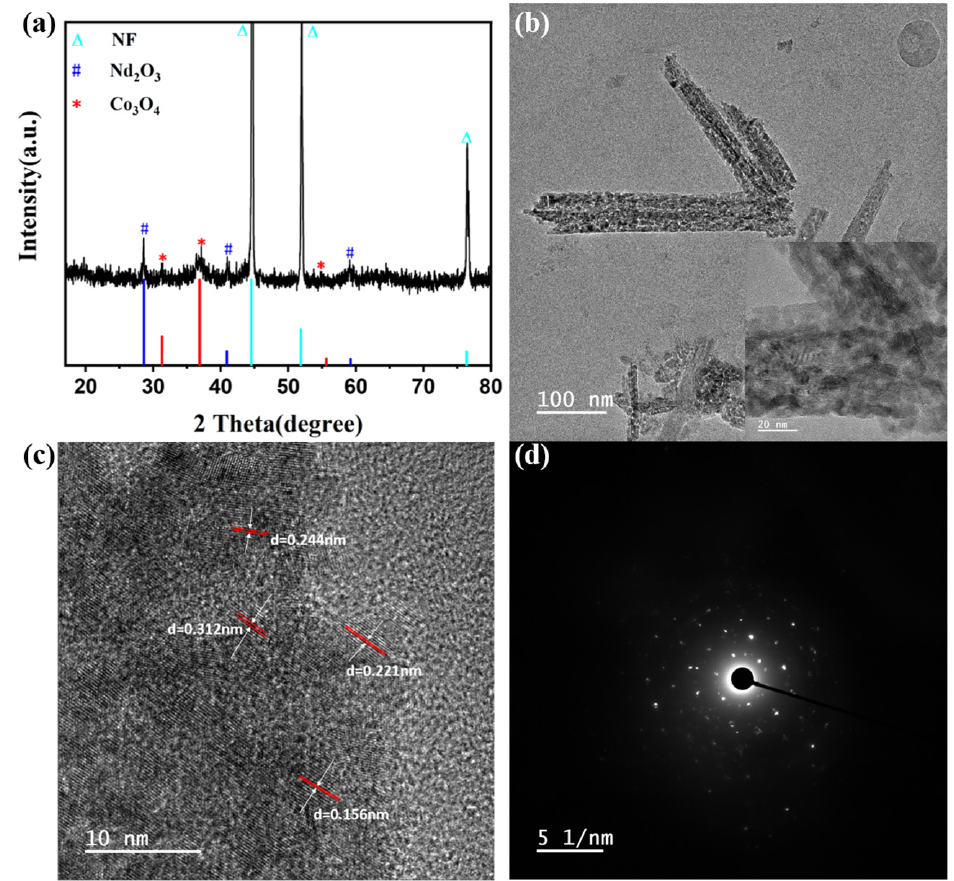
Figure 6. ( a ) TEM of Nd 2 O 3 /Co 3 O 4 /rGO/NF; the inset of ( a ) is the magnified view of nanosheet; ( b ) HRTEM image; ( c ) SEAD pattern of Nd 2 O 3 /Co 3 O 4 /rGO/NF and ( d ) XRD of Nd 2 O 3 /Co 3 O 4 /rGO/NF.